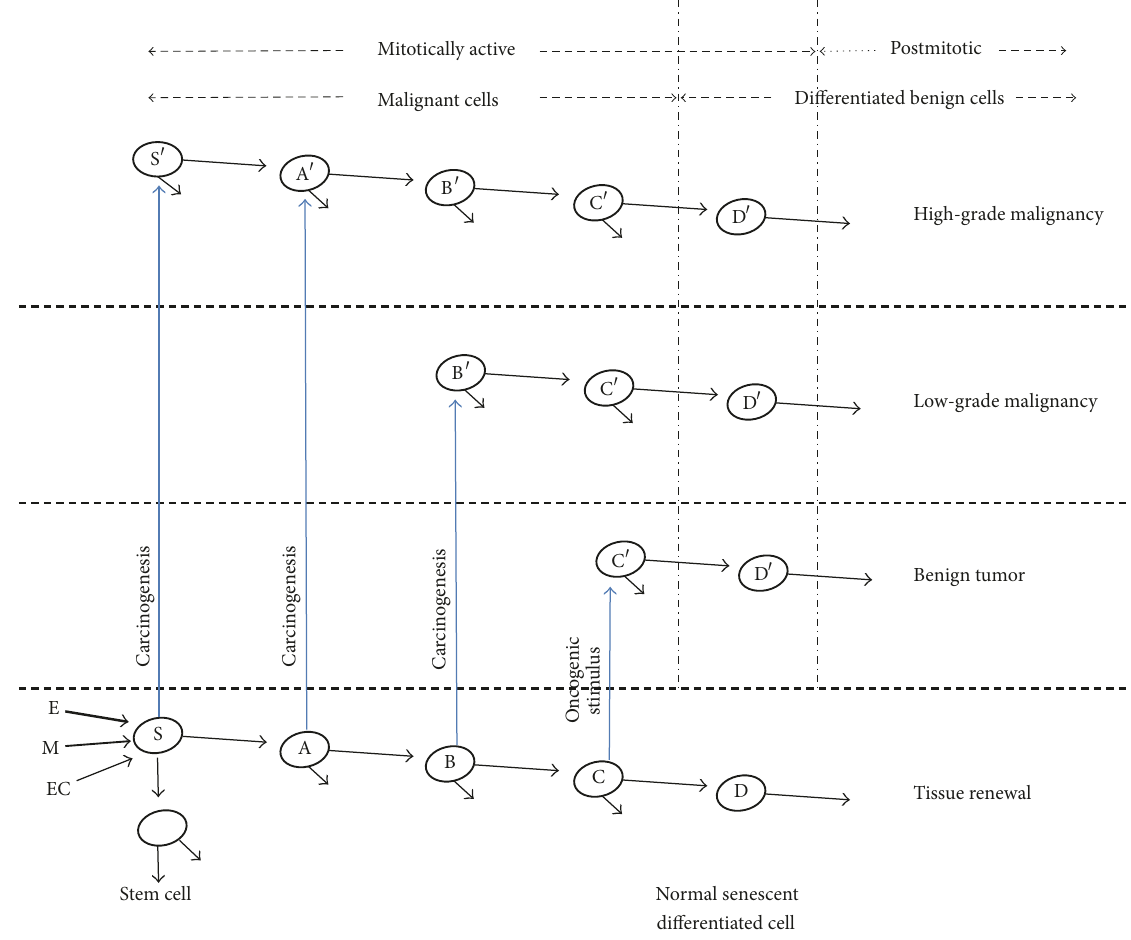
Figure 5: Differentiation and neoplasia. The normal cell lineage is at the bottom. Carcinogenesis may involve S, A, B, or C cells individually, giving origin to their corresponding malignant cell types. Their potentials for differentiation are indicated by the arrows. The cancers of endodermal and mesodermal origin are always the worst (thick arrow) in comparison with the ectodermal cancers (thin arrow) with a few exceptions as outlined in the article. EC: ectodermal origin; M: Mesodermal origin; and E: endodermal origin. Adapted from Pierce,